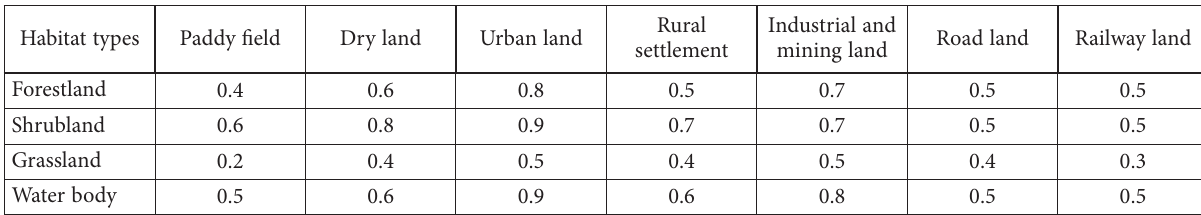
Table 2. Sensitivity of the threat factors to the respective habitat